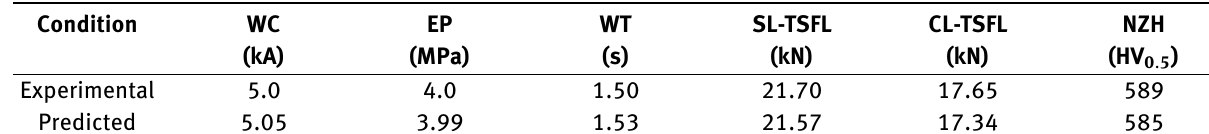
Table 4: Optimized RSW parameters for joining AHSS-DP800 steel Condition